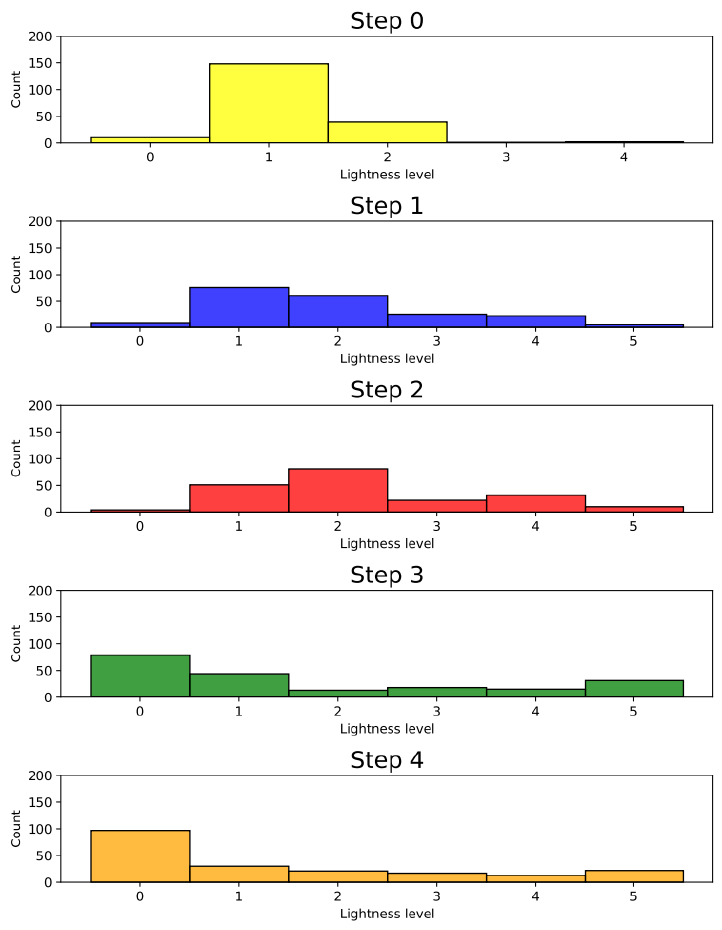
Figure 3. Lightness level distribution of the VITA SYSTEM 3D-MASTER for each step. Table 4. Means and standard deviations of L, a, and b values for all groups for each specified